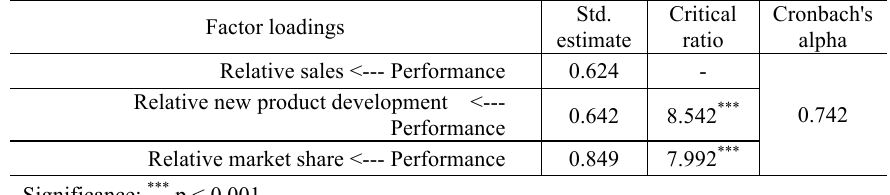
Table 2. Confirmatory factor analysis result